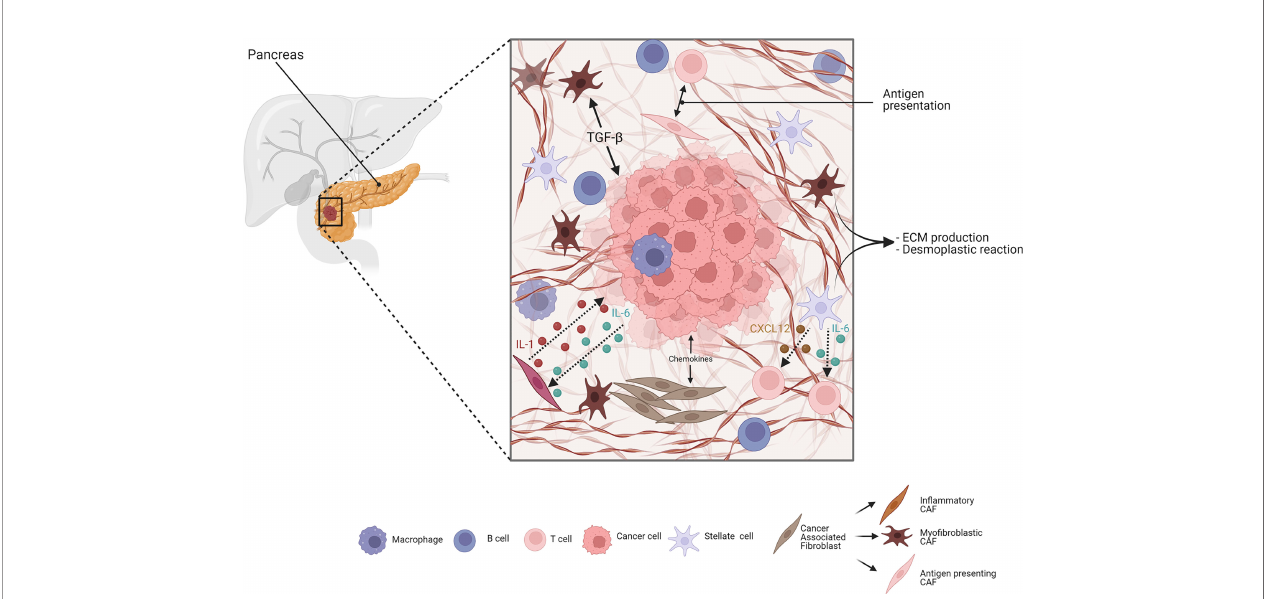
FIGURE 1 | Simpli fi ed scheme of stroma-mediated interaction in PDAC. Cancer-associated fi broblasts (CAFs) are crucial elements of the pancreatic ductal adenocarcinoma (PDAC) stroma. They include different subtypes: myo fi broblastic, in fl ammatory, and antigen-presenting subtypes. Both cell – cell and paracrine interaction CAFs and PDAC cells are involved in manipulating the stroma. The cancer cells can induce, through transforming growth factor- b (TGF b ) signaling, the surrounding CAFs to adopt a my fi broblastic phenotype. Similarly, cancer cells produce IL-1, reprogramming CAFs to in fl ammatory CAFs, which, in turn, produce chemokines like IL-6 and sustain cancer growth. Antigen-presenting CAFs, expressing MHC class II molecules, modulate the immune cells in the stroma. Pancreatic stellate cells (PSCs) are mainly responsible for ECM deposition during PDAC, and are also able to modulate the immune response through the production and secretion of cytokines, such as CXCL12 and IL-6, negatively affecting T-cell activity and migration. Adapted from “ PDAC histology ” by BioRender.com (2022). Retrieved from